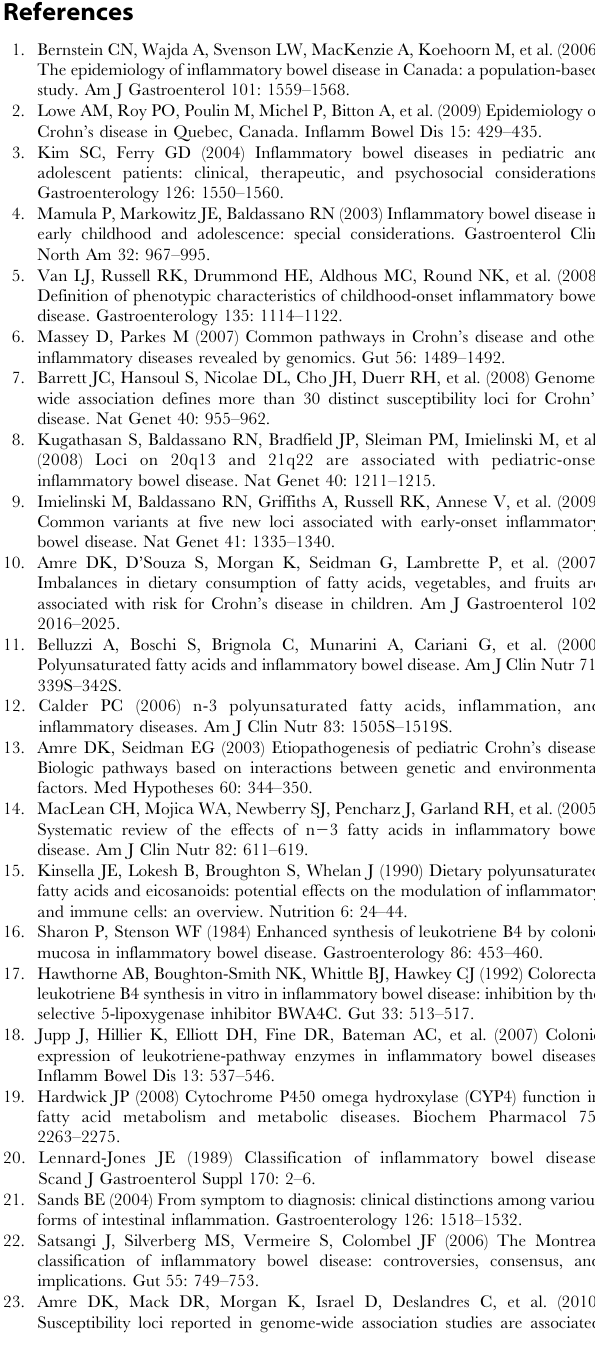
Table S2 Associations between the CYP4F2 gene and risk for CD in Canadian